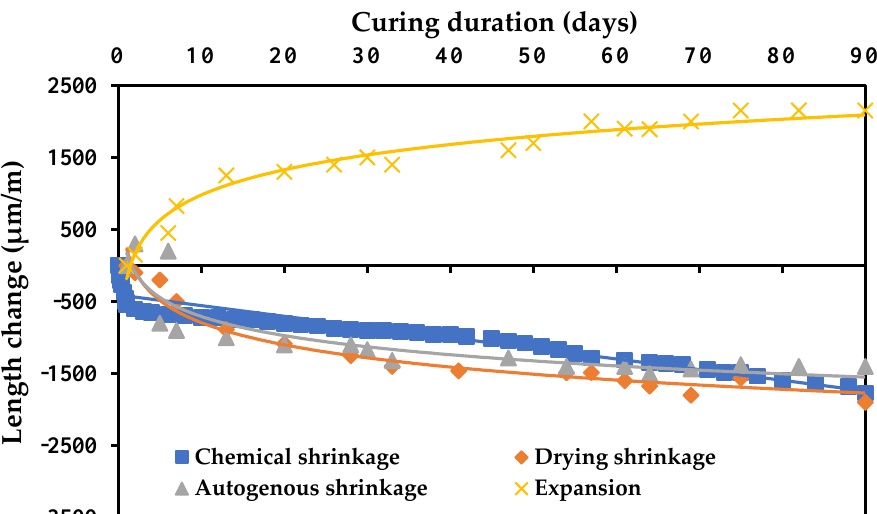
Figure 14. Length change of pastes with 20% LF.